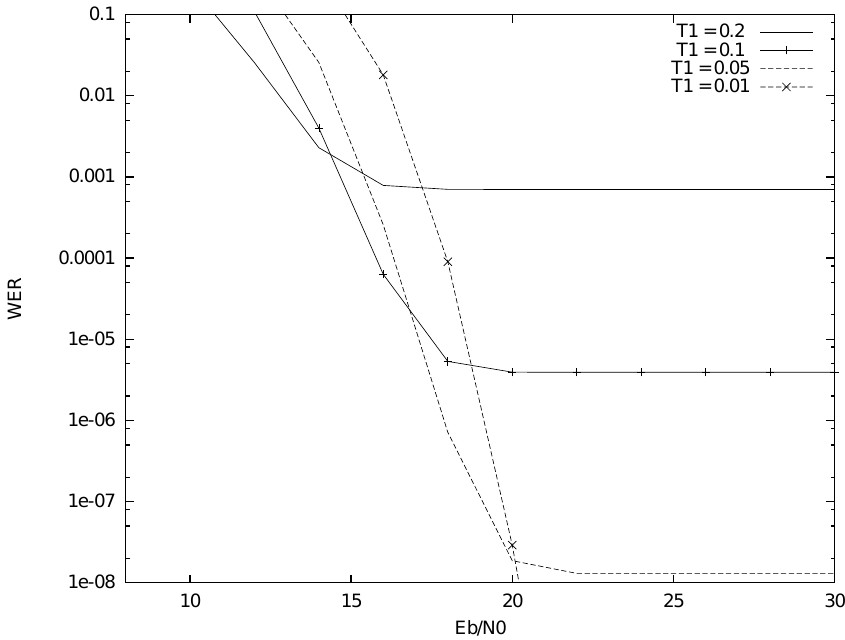
Figure 3. WER vs. E b / N 0 for truncated channel inversion with comparing a threshold.